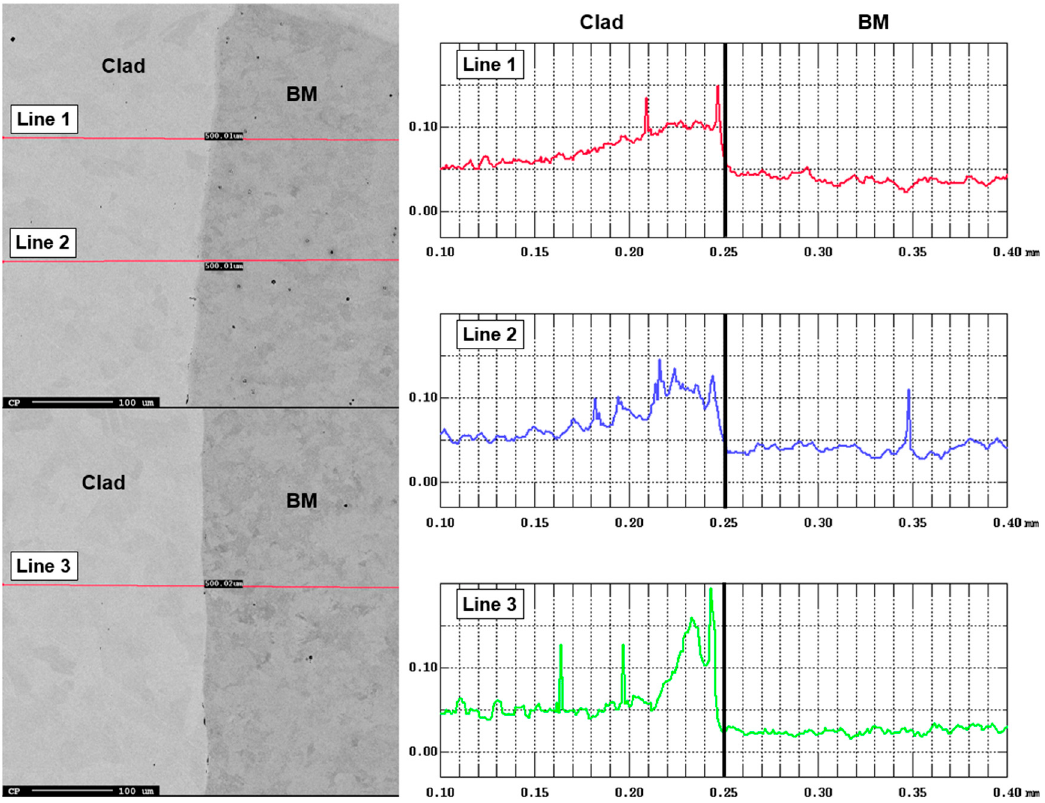
Figure 2. Variation of carbon content (wt %) across the clad/pipe interface [21]. Lines 1, 2, and 3 represent measurement distance and BM is base metal.